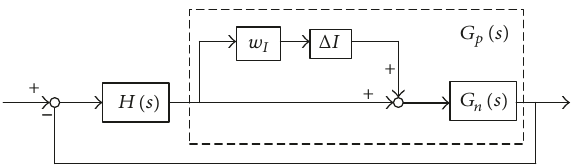
Figure 5: Feedback system with multiplicative